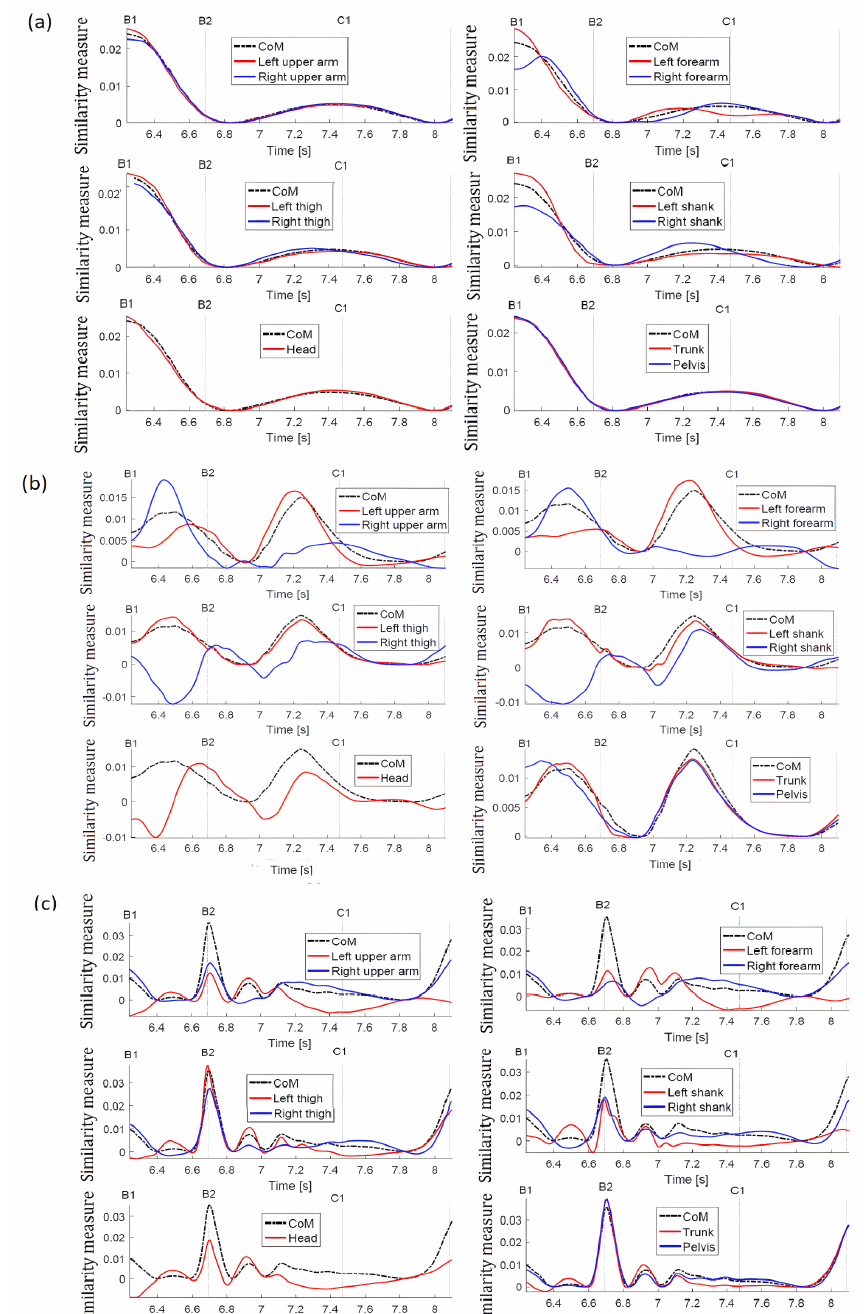
Figure 8. Trajectories of the similarity measure during the push recovery (free arms). ( a ) trajectories along the X-axis; ( b ) trajectories along the Y-axis; ( c ) trajectories along the